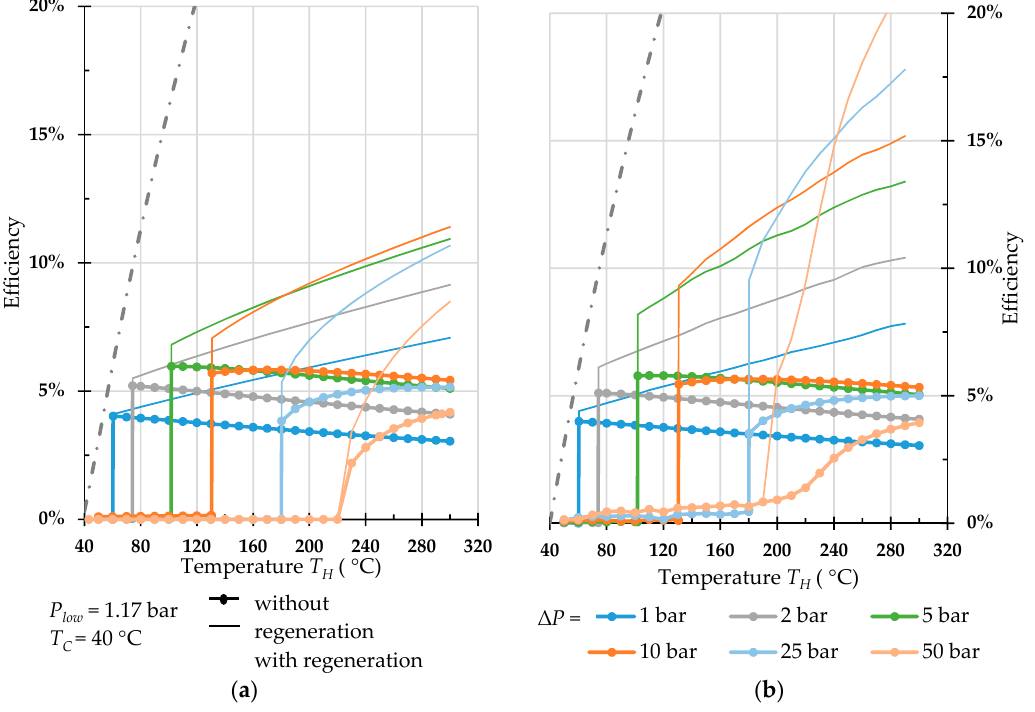
Figure 9. Efficiency of regenerative Worthington-type machine ( a ) and Bush-type machine ( b ) operated with pentane.